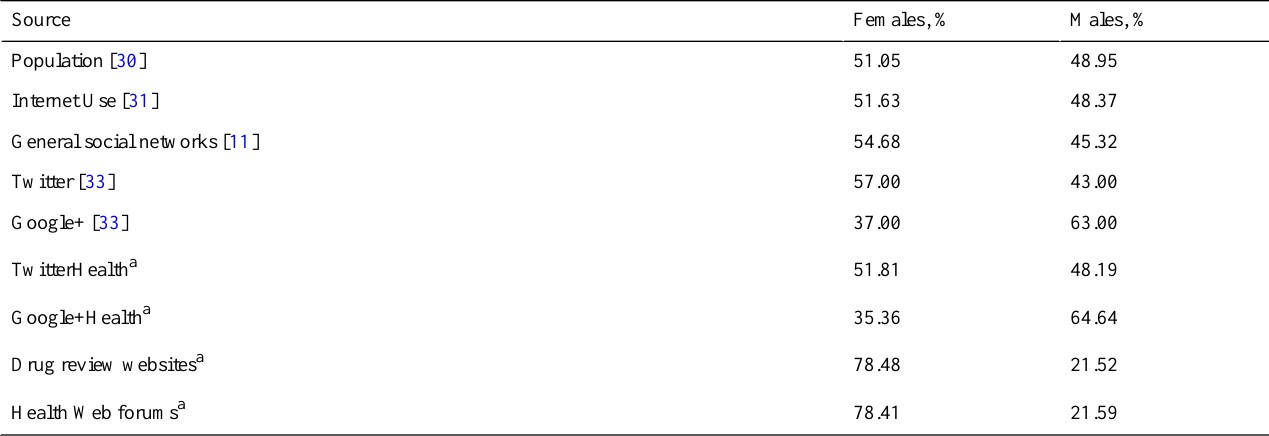
Table 3. Gender distribution for TwitterHealth, Google+Health, drug reviews, health forums, compared to other relevant populations.